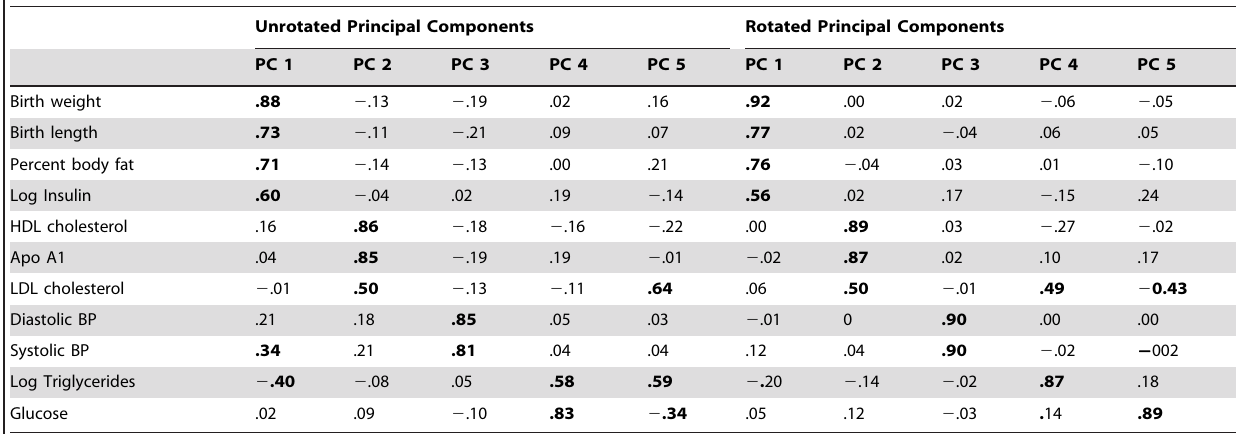
Table 7. Variable Loadings for the First 5 Principal